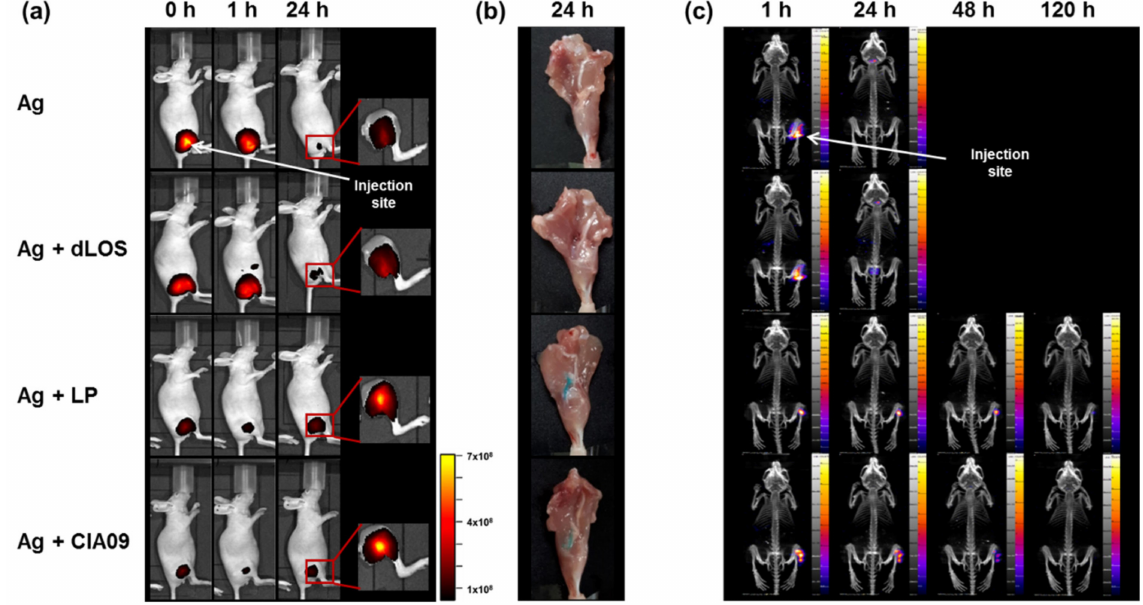
Figure 9. In vivo imaging of CIA09-adjuvanted gE antigen in mice. ( a ) Groups of mice ( n = 6) were injected with AF647- labeled gE (5 µ g), alone or in combination with dLOS (2 µ g), liposomes (LP) (100 µ g), or CIA09. Two mice from each group were monitored at 0, 1, and 24 h post-injection for the distribution of the fluorescence dye using in vivo imaging. Fluorescence detected at a lower scale are shown in photo inserts. The data shown are representative of two independent experiments with similar results. ( b ) Mouse legs taken at 24 h were opened to monitor fluorescence. An image of one mouse from each group is shown. ( c ) Mice were injected with 125 I-labeled gE (20 µ g), alone or in combination with dLOS (1 µ g), liposomes (100 µ g), or CIA09, and their SPECT/CT images were obtained at 1, 24, 48, and 120 h post-injection. Arrows mark injection